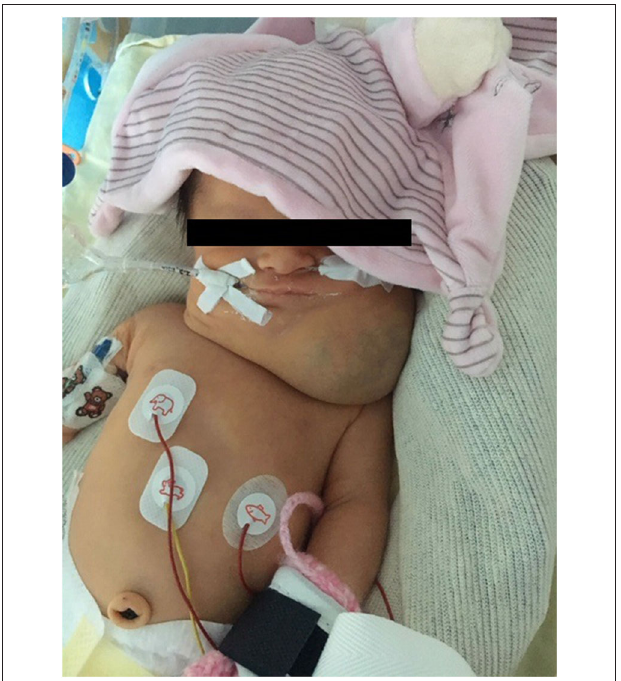
FIGURE 1 | Photograph illustrating the clinical aspect of the cervical mass at 1 day of